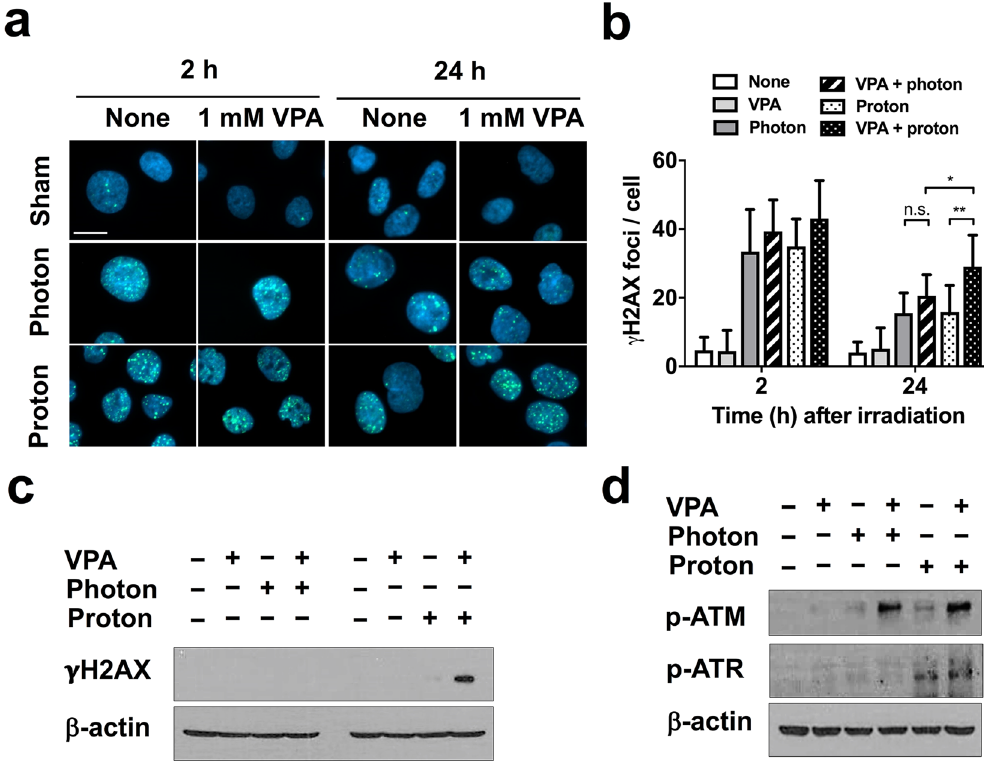
Figure 4. VPA attenuates radiation-induced DNA damage repair in Hep3B cells. ( a ) DNA damage repair after photon or proton irradiation was assessed by γ -H2AX immunostaining. γ -H2AX foci (green) in nuclei (blue) were visualized at 2 h and 24 h after irradiations. Scale bar, 20 µ m. ( b ) Quantification of the number of γ -H2AX foci per cell. Data are mean values ± SD of twelve cells. n.s., not significant; * p < 0.05; ** p < 0.01. ( c ) Western blot analysis reveals combined treatment with proton and VPA led to delayed abrogation of γ -H2AX. ( d ) Combined treatment with proton and VPA led to persistent activation of ATM and ATR. The samples were harvested 72 h after 6 Gy irradiation. β -actin is used as a loading control. The cropped blots are presented and their full-length blots are included in the Supplementary Fig.